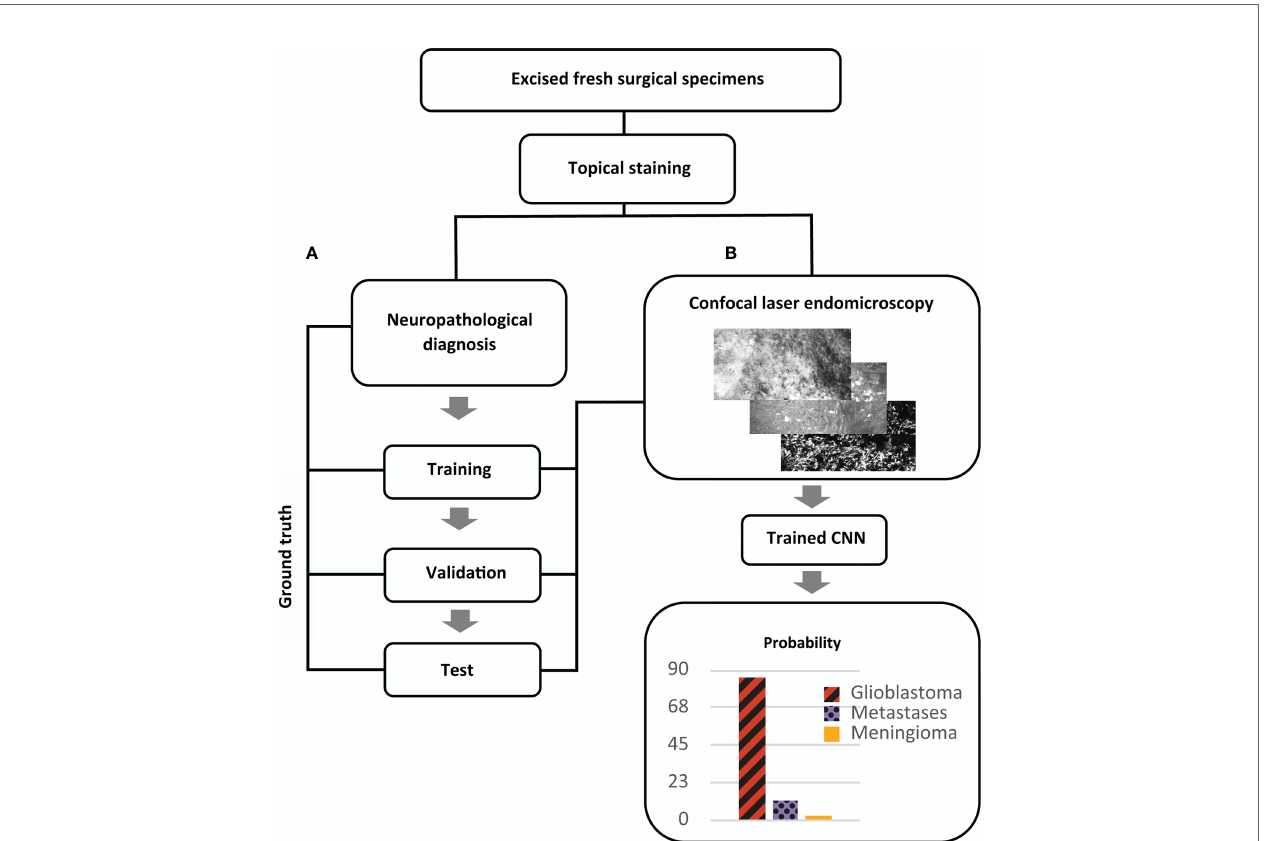
FIGURE 5 | Proposed pipeline for intraoperative diagnosis of brain tumors with confocal laser endomicroscopy after image acquisition, training and test phase of a convolutional neural network (CNN). (A) Experimental design for construction and validation of a CNN for multiclass classi fi cation of brain tumors. Fresh specimens are stained with fl uorescein dye, and images are acquired with confocal laser endomicroscopy (CLE) by a single user. Afterwards the specimens undergo histopathological diagnostics (as described in Materials and Methods ) providing ground truth for training and validation of the CNN. CLE contained a portable hand held probe and a touch screen. (B) Schematic work fl ow for ex vivo brain tumor diagnosis providing CLE images with an additional con fi dence level. By applying a con fi dence threshold, non-diagnostic images are not considered for